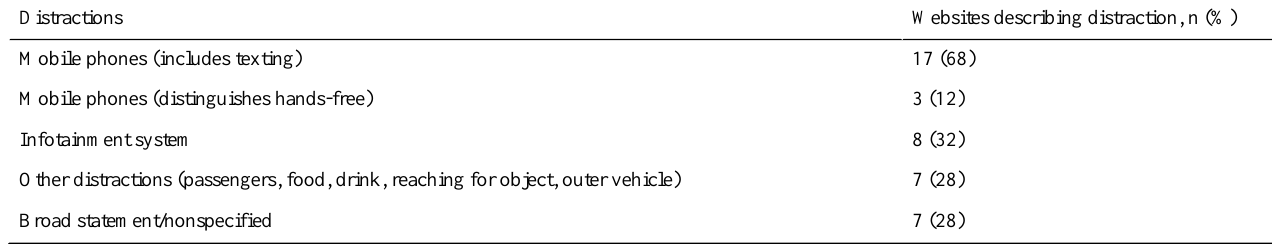
Table 2. Distractions described in websites for distracted driving. Many websites identified multiple distraction types.